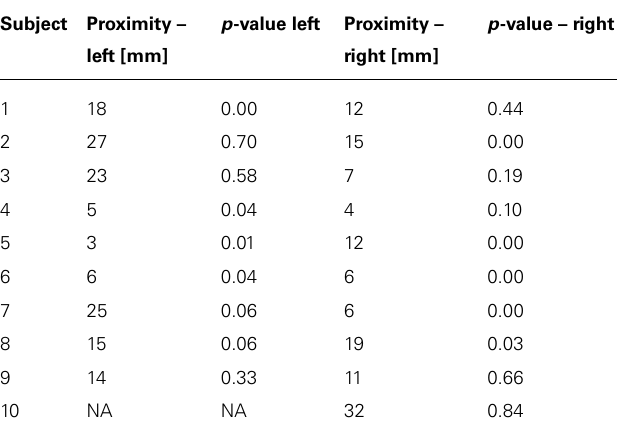
Table 2 | Results of the proximity analysis for all 10 subjects and left/right imagery.